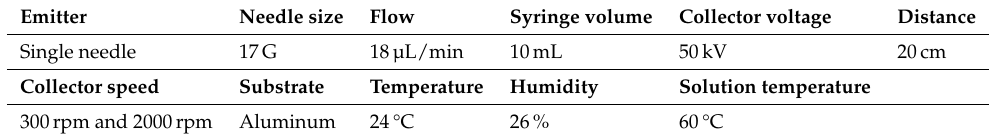
Table 1. An overview of the processing parameters under which the fibers in this study were